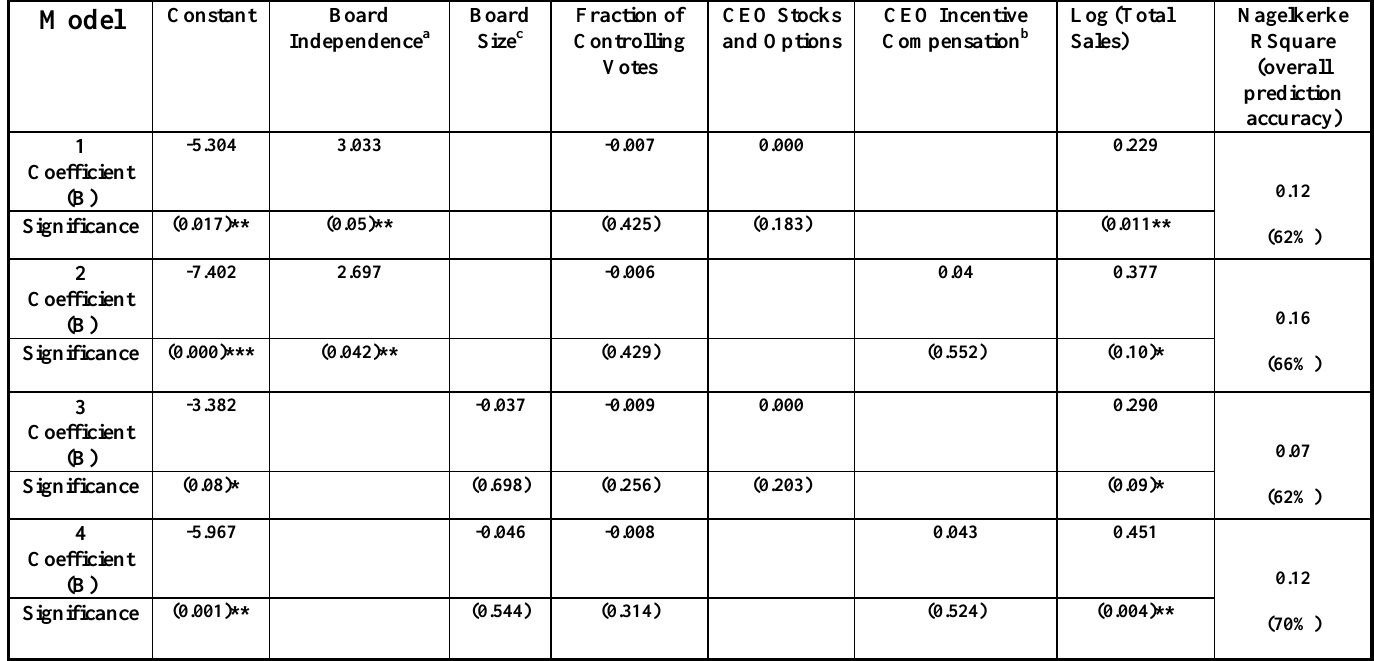
Table 4: Risk Disclosure and Corporate Governance Logistic Regression Results